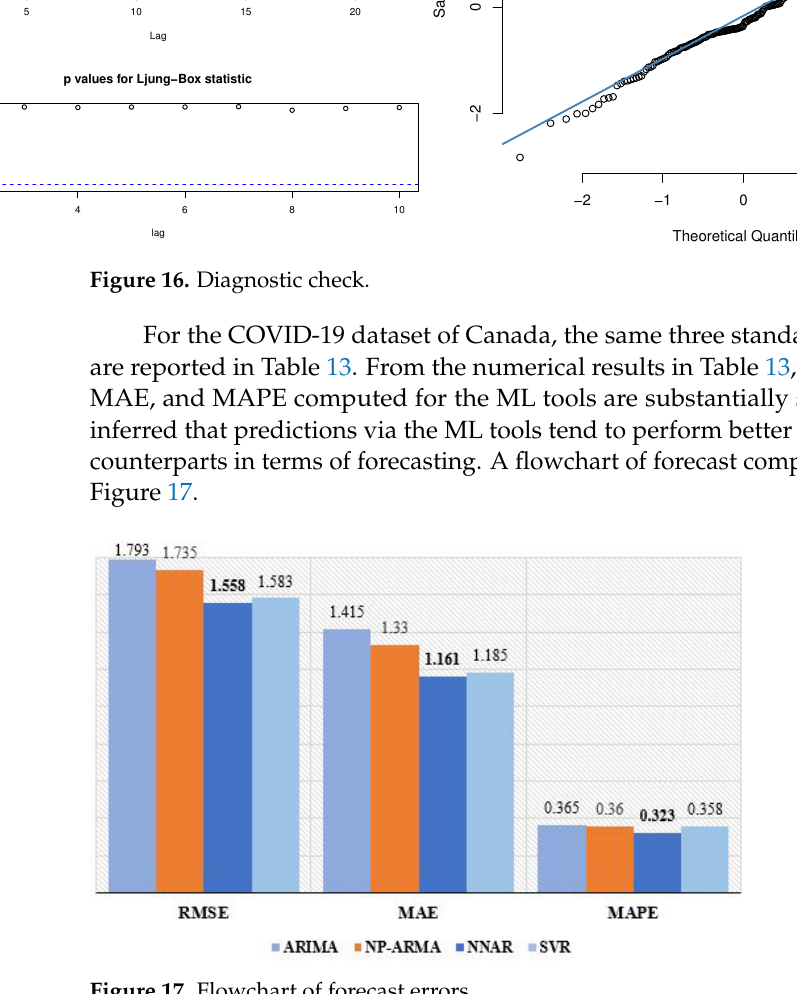
Figure 17. Flowchart of forecast